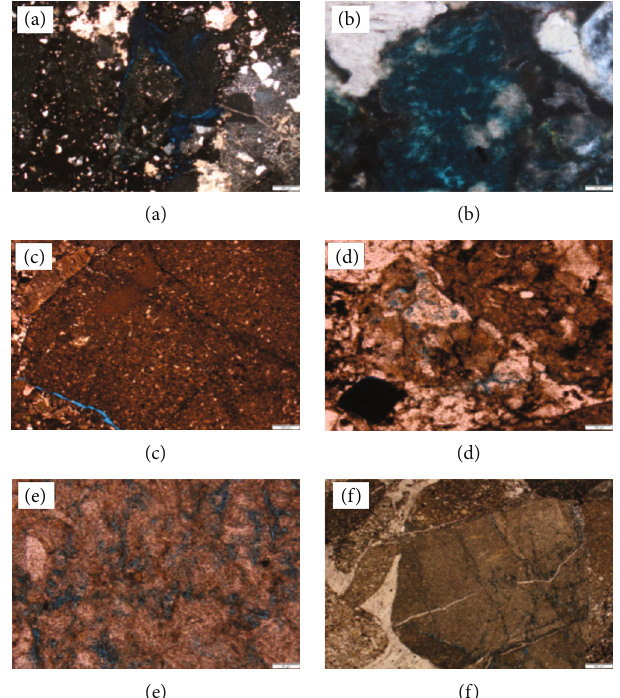
Figure 10: Microcast thin section images of cores: (a) microcracks around tu ff gravel (crack widths 13-531 μ m); (b) glass shard solution pores; (c) silty mudstone gravel chip; (d) microcracks in fi ller; (e) mudstone gravel containing silt; (f) cracks in fi ne siltstone gravel (crack widths 20-51 μ m).